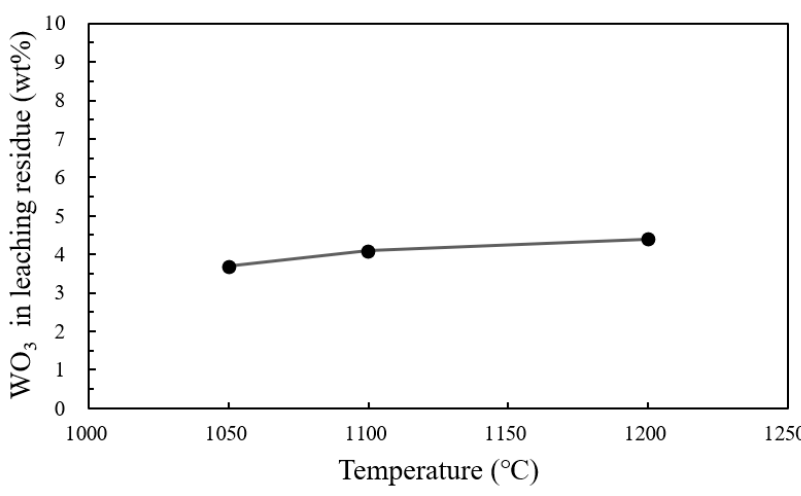
Figure 6. Effect of temperature on WO 3 in leaching residue in air with 39.83% Na 2 O and 40% SiO 2 .